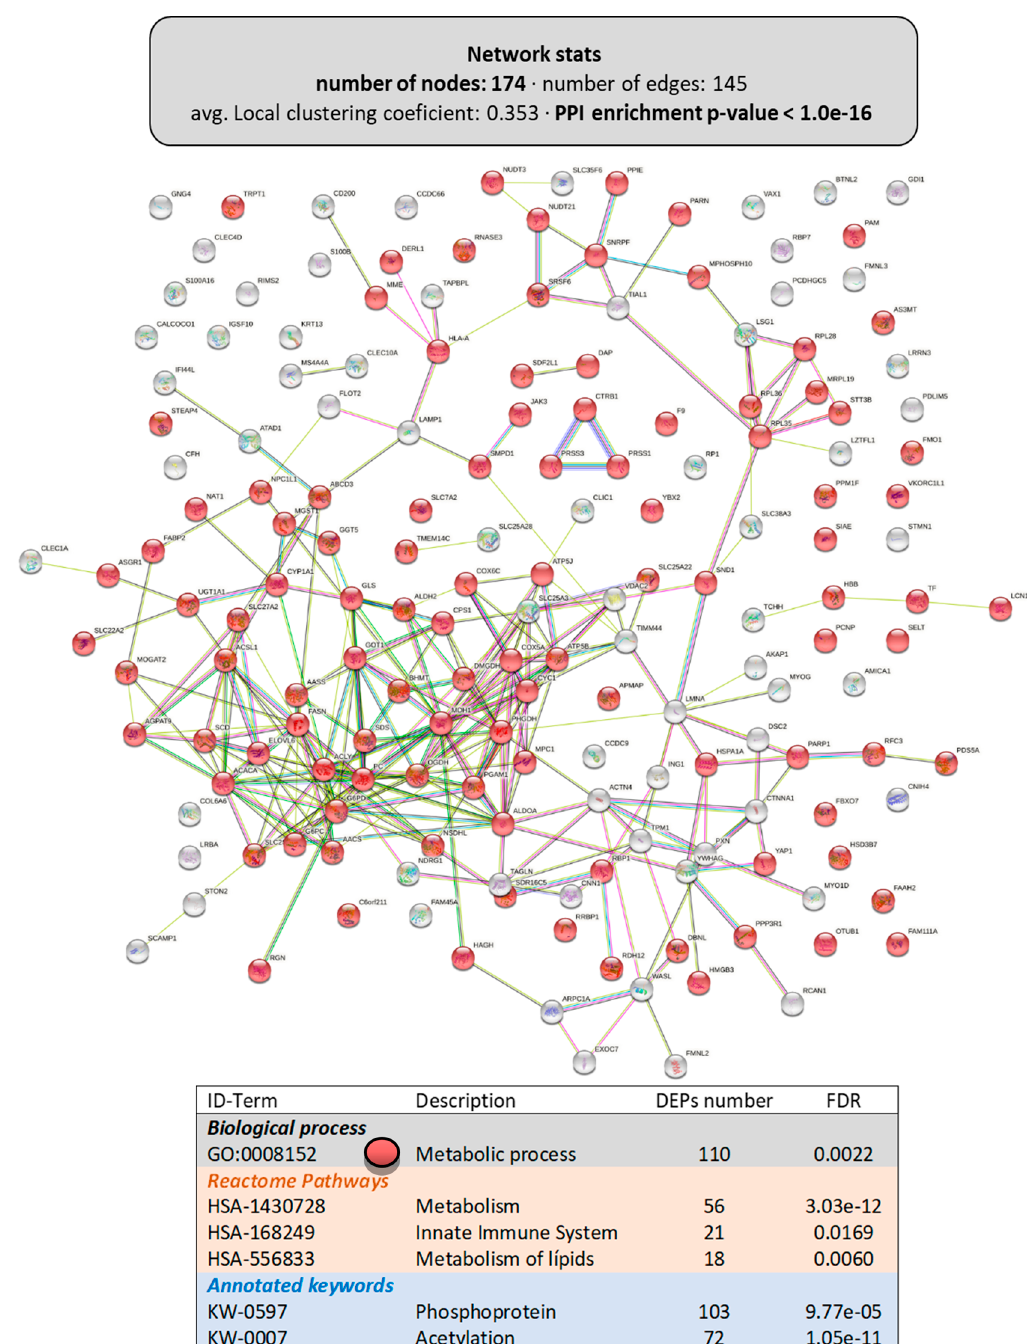
Figure 6. Functional enrichments in the interactome of the liver of LPL-fed salmon. Each node represents one differentially expressed protein (DEP) obtained from liver shotgun proteomics (details in Supplementary Files S3 and S4). Details on the functional network statistics (network stats) are indicated ( top ). The selected relevant biological processes ( bottom ) are presented with the corresponding colors in each node. The main Reactome pathways and post-translational modifications (PTMs), clustered significantly by the false discovery rate (FDR) value, are also summarized ( bottom table ).